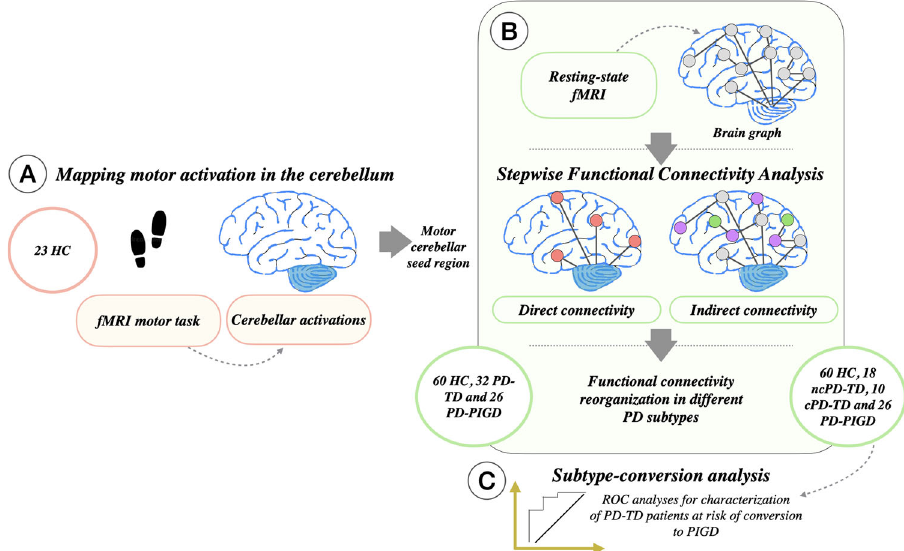
Fig. 1 Study framework. A Mapping motor activation in the cerebellum. B Cortical connectivity diagram of a selected area in the cerebellum using stepwise connectivity analysis. Cortical maps show characterization of direct and indirect functional connectivity from motor cerebellar seed region. Functional connectivity reorganization was then evaluated in different PD subtypes. C ROC analyses for characterization of PD-TD patients at risk of conversion to PIGD. c, converter; fMRI, functional MRI; HC, healthy controls; nc, non-converter; PD-TD, Parkinson ’ s